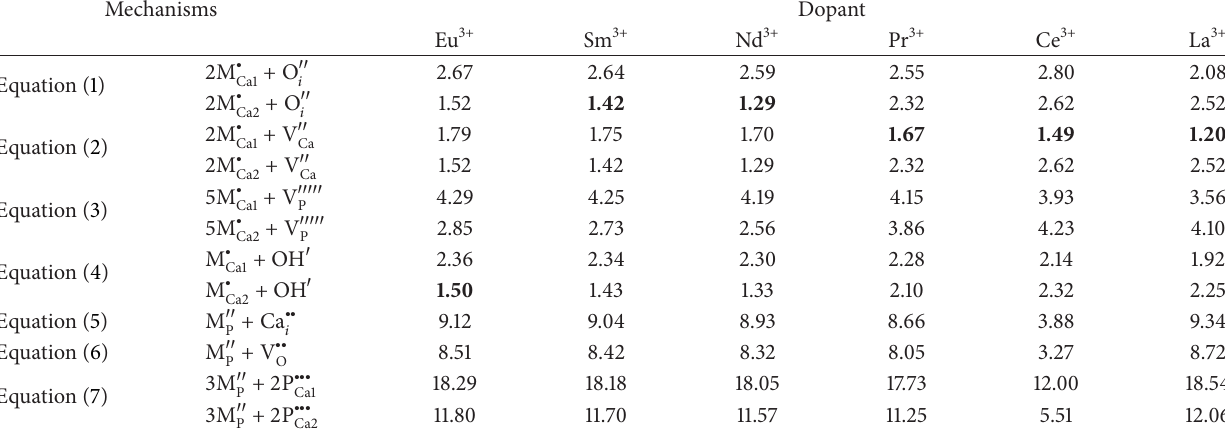
Table 7: Solution energies (eV) for substitution of the rare earth (M 3+ = Eu, Sm, Nd, Pr, Ce, and La) ions in